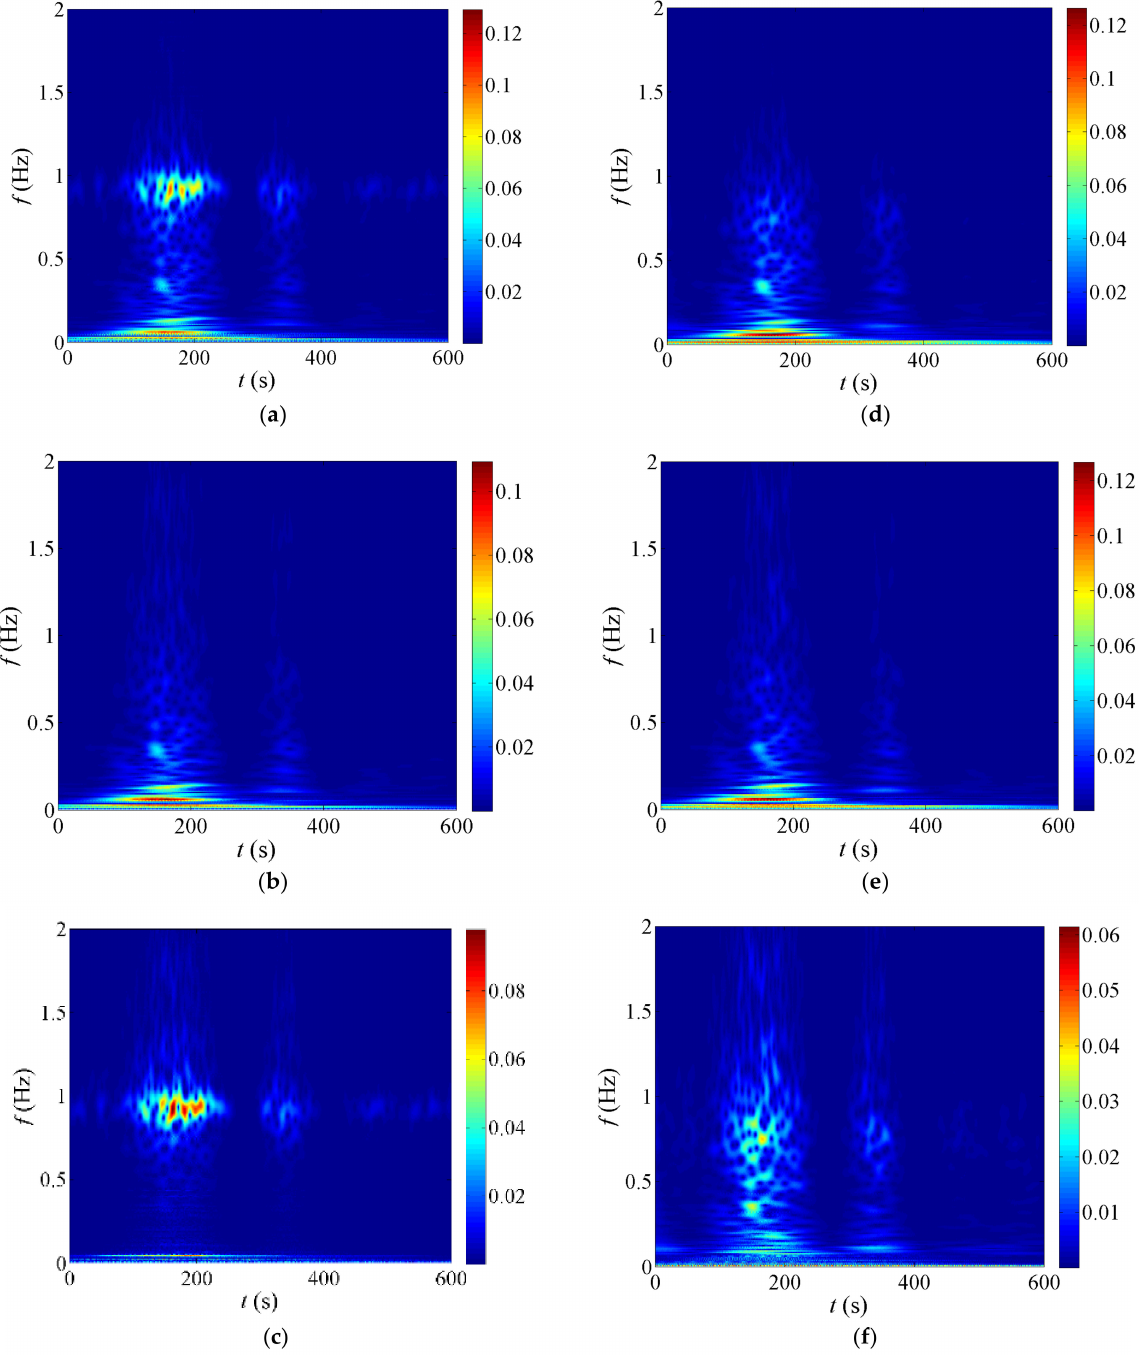
Figure 9. Time frequency diagram of the fluctuating displacement response of the tower top. Single tower: ( a ) fluctuating response; ( b ) fluctuation background component; ( c ) fluctuation resonance component. Tower-line system: ( d ) fluctuating response; ( e ) fluctuation background component; ( f ) fluctuation resonance